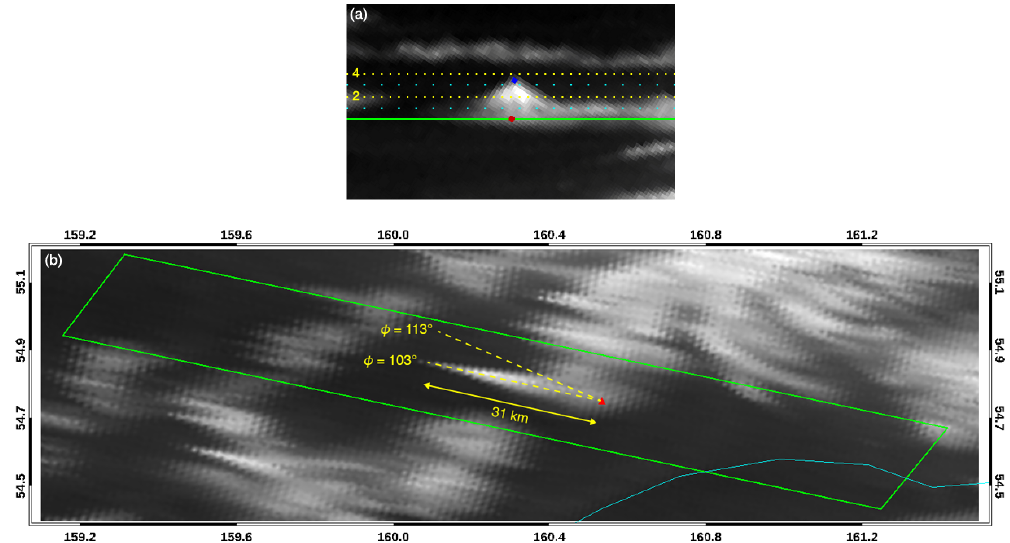
Figure 8. GOES-17 band 2 image of Kronotsky (3528m) on 13 June 2020 at 23:00UTC in (a) fixed grid projection (8 × magnification) and (b) equirectangular (Plate-Carrée) projection. In panel (a) , the red and blue diamonds mark the volcano base and peak, respectively, and the horizontal lines are base-relative isoheights drawn at 1km intervals (solid green: surface, cyan dotted: odd numbers, yellow dotted: even numbers). In panel (b) , the green quadrilateral bounds the area shown in panel (a) , the red triangle indicates the volcano base, and the cyan curve is the coastline. The true view azimuth ( φ = 113 ◦ ), the apparent (distorted) azimuth ( φ = 103 ◦ ), and the ellipsoid-projected distance between the base and peak locations are also